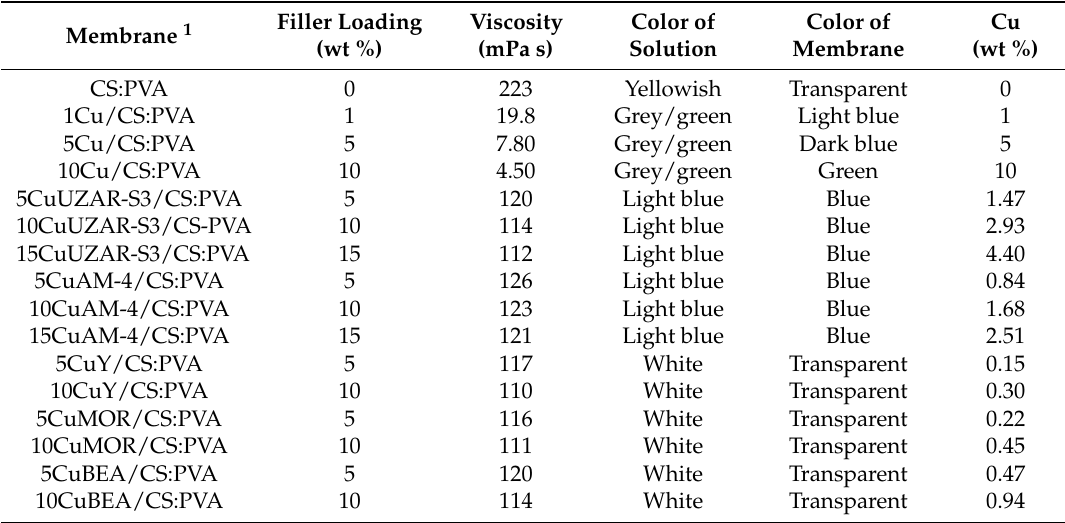
Table 1. Description of the membranes